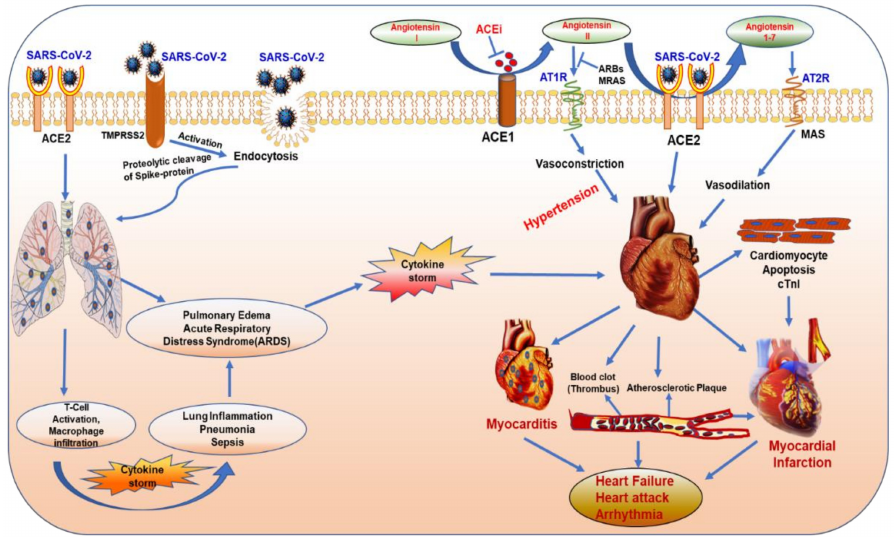
Figure 3. Pulmonary and cardiovascular complications associated with COVID-19